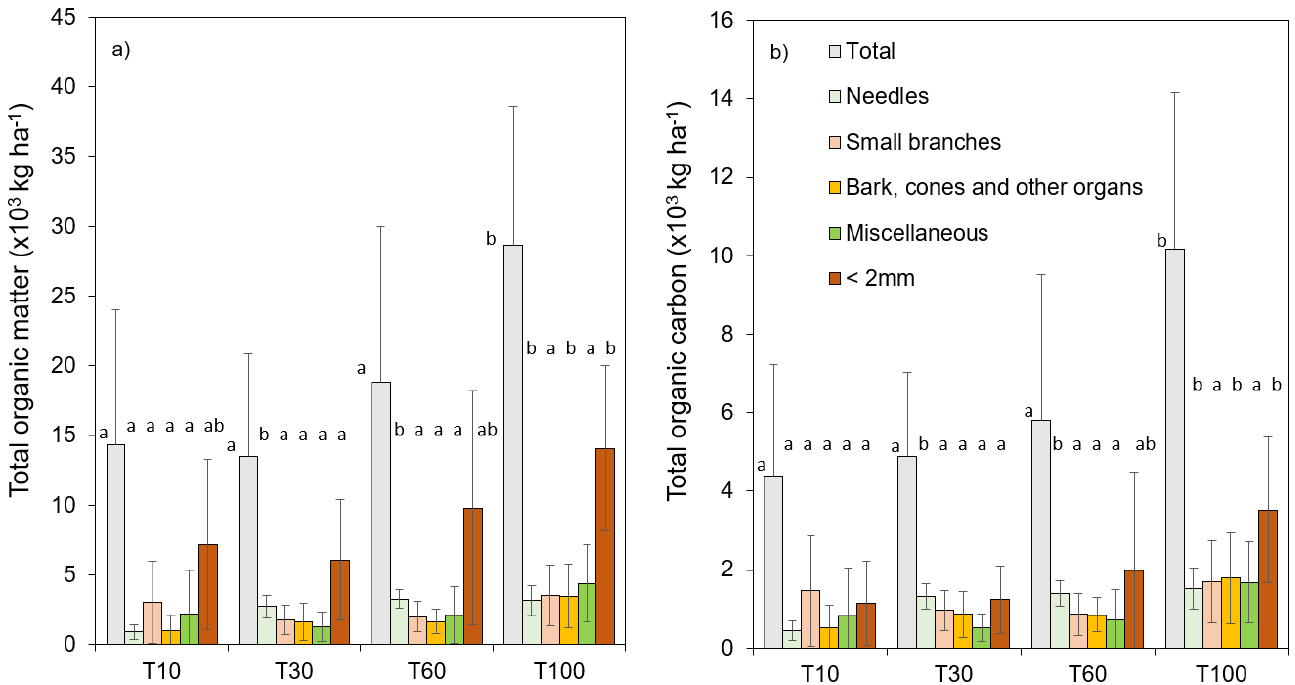
Figure 1. Variation in the forest floor fractions (means and standard deviations) between the thinning treatments: ( a ) total organic matter ( × 10 3 kg · ha − 1 ), ( b ) total organic carbon (TOC ff , × 10 3 kg · ha − 1 ). Lower case letters denote significant differences (Tukey’s HSD post hoc test) for the factor thinning treatment at p -value < 0.05. Table 2. Mean ± standard deviation values for soluble organic carbon (WOC ff ), total N ff , C/N ff relationship, and basal respiration for the fine fraction of the forest floor after 28 days of incubation (BR ff ). Lower case letters denote significant differences (Tukey’s HSD/Tamhane’s T2 post hoc tests) for the factor thinning treatment at p -value <